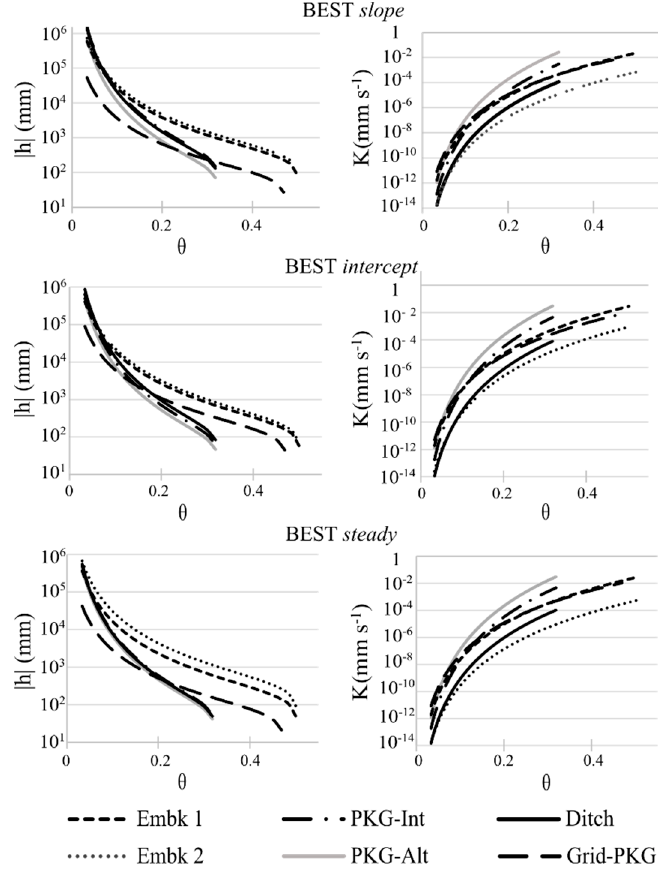
Figure 5. Hydrodynamic characteristic curves K( θ ) and h( θ ) of the studied soils obtained by the three BEST methods.